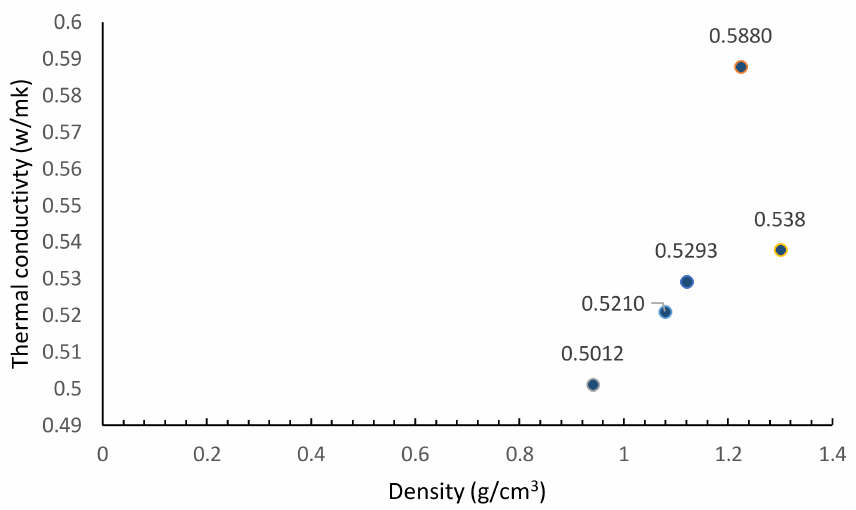
Figure 17. Thermal conductivity of aerated slurries versus their